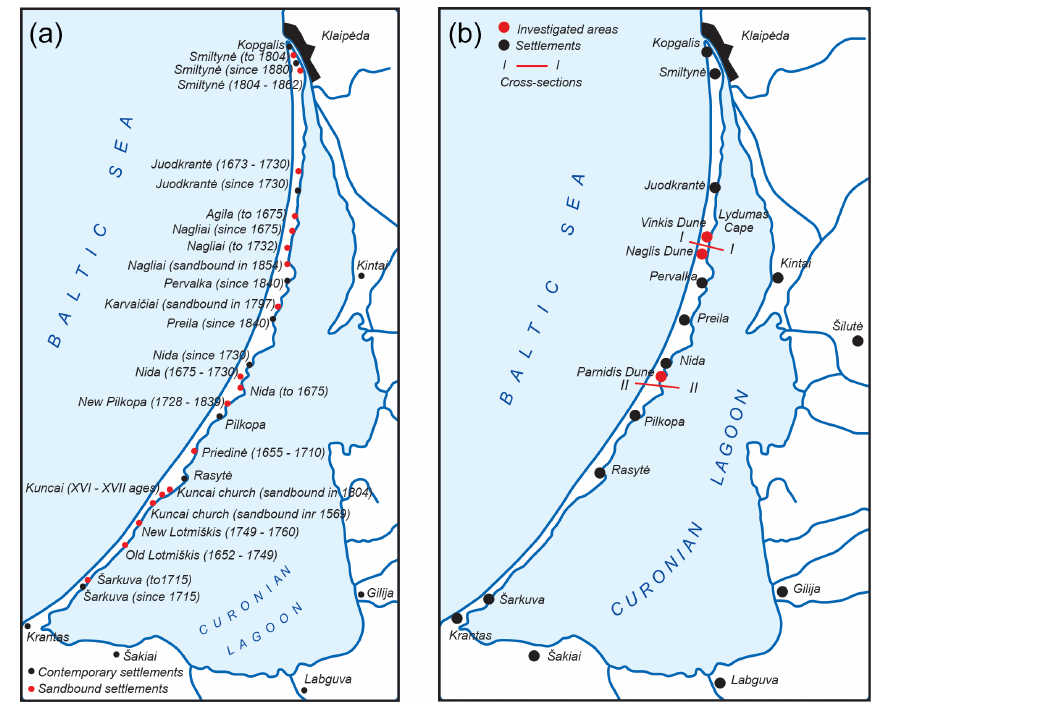
Figure 3. Contemporary and extinct settlements (a) and investigated areas (b) . Places of cross sections: I–I – Vingiakop˙e environment (Fig. 1); II–II – Parnidis environment (Fig. 4).